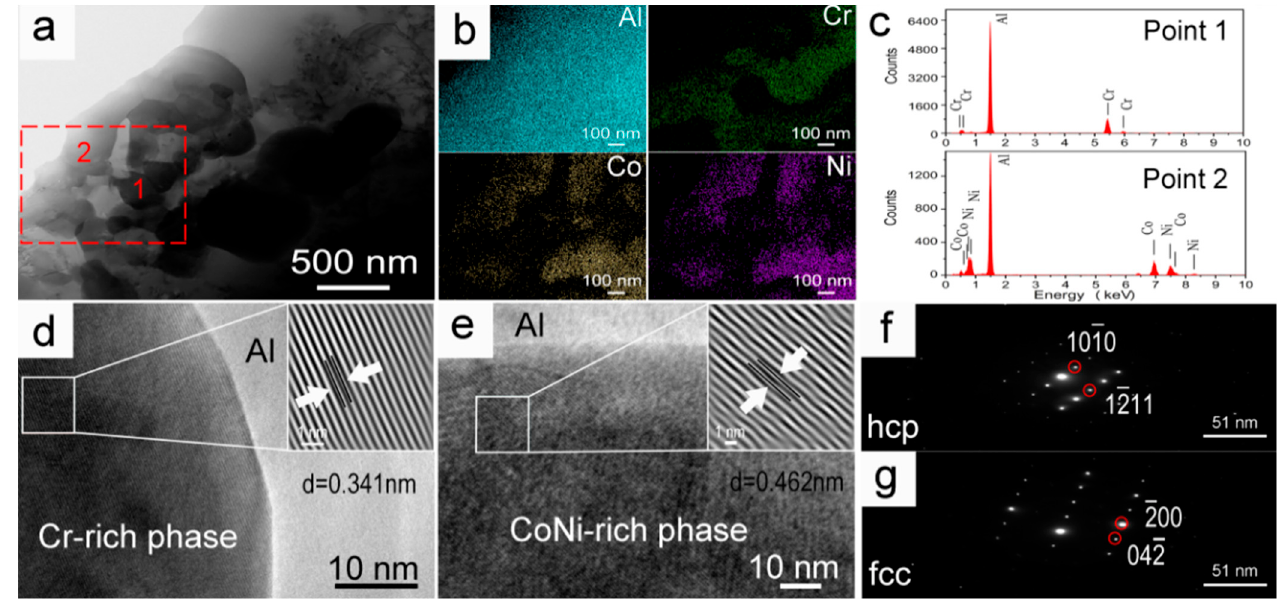
Figure 6. TEM observation of the 10 wt.% CrCoNi/Al composite. ( a ) the bright field TEM image; ( b ) elemental mapping results recorded from the rectangular region in ( a ); ( c ) the EDS results recorded from point 1 and point 2 marked in ( a ); ( d ) HRTEM image of the interface area between the Cr-rich phase and the Al matrix; ( e ) HRTEM image of the interface area between the CoNi-rich phase and the Al matrix; ( f ) SAED pattern acquired from the white rectangular region in ( d ); ( g ) SAED pattern acquired from the white rectangular region in ( e ).